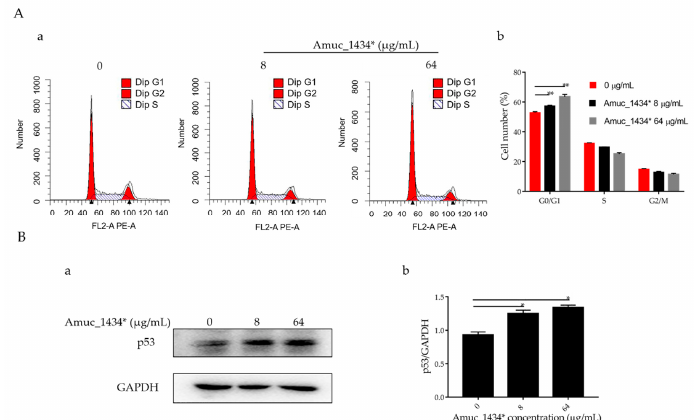
Figure 2. Amuc_1434* treatment induced G0/G1-phase cell-cycle arrest. ( A ) Cell cycle analysis. (a) LS174T cells were treated with Amuc_1434*, and cell-cycle distribution was evaluated by flow cytometry. (b) Percentages of G0/G1 phase of the cell cycle in LS174T cells are shown. (Data are expressed as mean ± standard deviation, n = 3, *: p < 0.05.) ( B ) Western blotting analysis for the expression level in LS174T cells of tumor protein 53 (p53) (a), which controls the start of the cell cycle, after treatment with Amuc_1434*. GAPDH was used as the loading control. (b) Quantification of p53 expression levels in LS174T cells. (Data are expressed as mean ± standard deviation, n = 3, *: p < 0.05.)